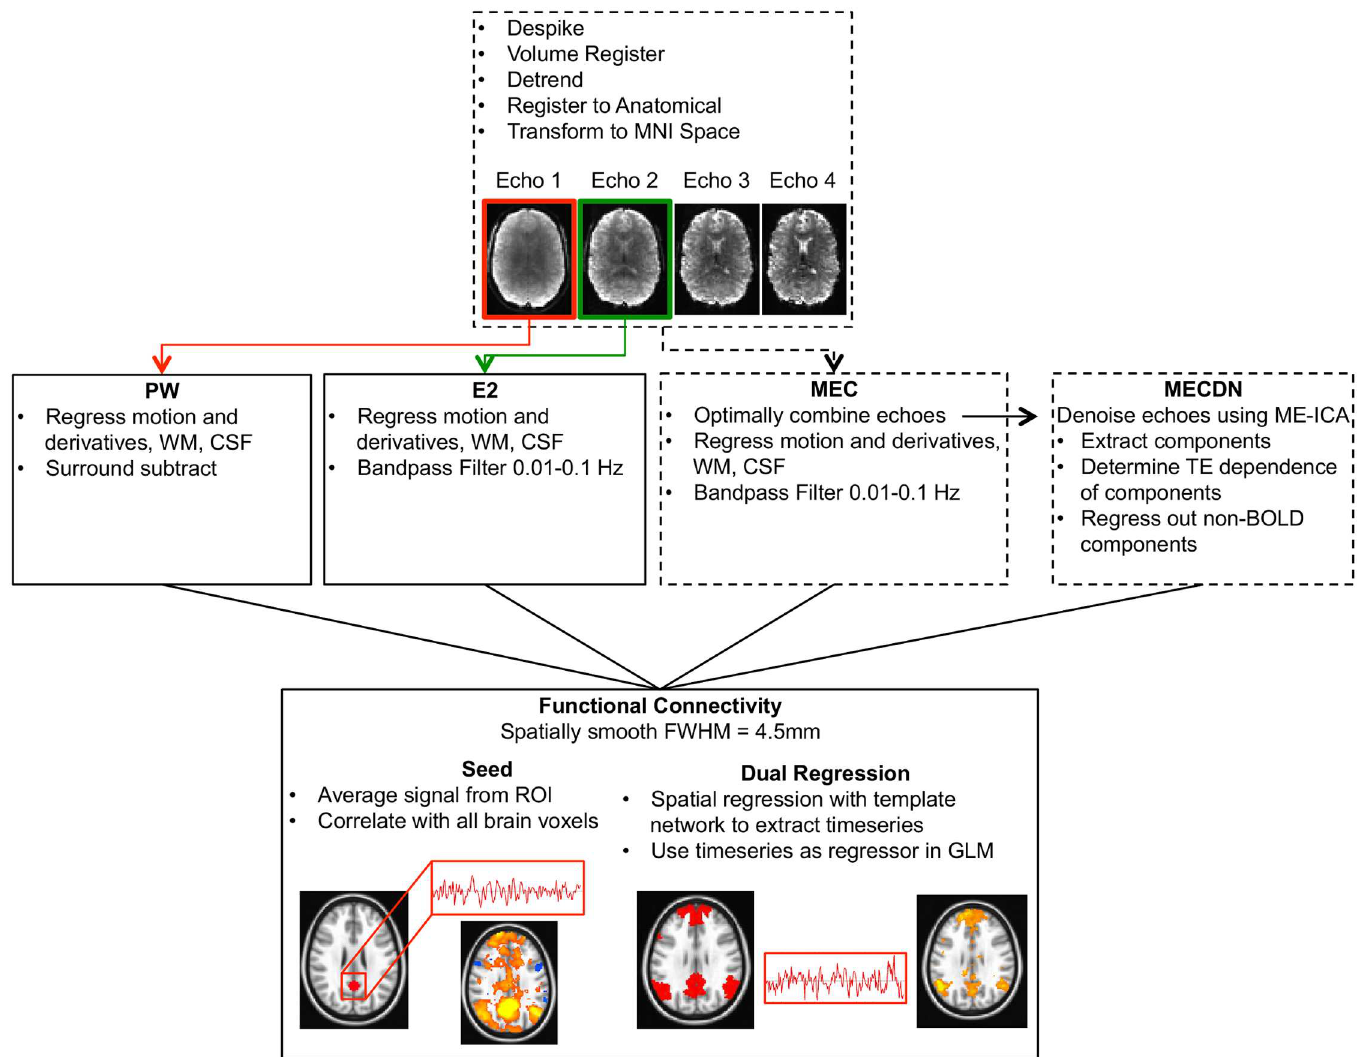
Fig 2. Schematic showing the resting state functional connectivity pipeline for the ASL and BOLD echoes. The first and second echoes were processedseparately to yield the PW and E2 data respectively. Echoes were also combinedusing a T2 * -weighted approachto generatethe MEC dataset. This dataset was further denoised using ME-ICA resultingin the MECDN dataset. Each echo was despiked,volume registered using the transformation matrix from the first echo, detrended, registeredto the anatomical image, and transformed to MNI space. Additional preprocessingsteps differ for each dataset and are shown in Row 2. For all datasets, after preprocessing, functionalconnectivity was assessedwith seed-based and dual-regression approaches(Row 3).